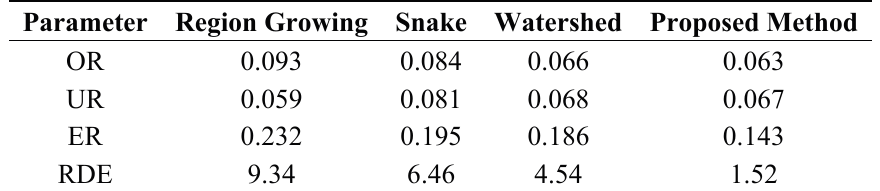
Table 2. Performance evaluation via average error measure of OR, UR, ER and